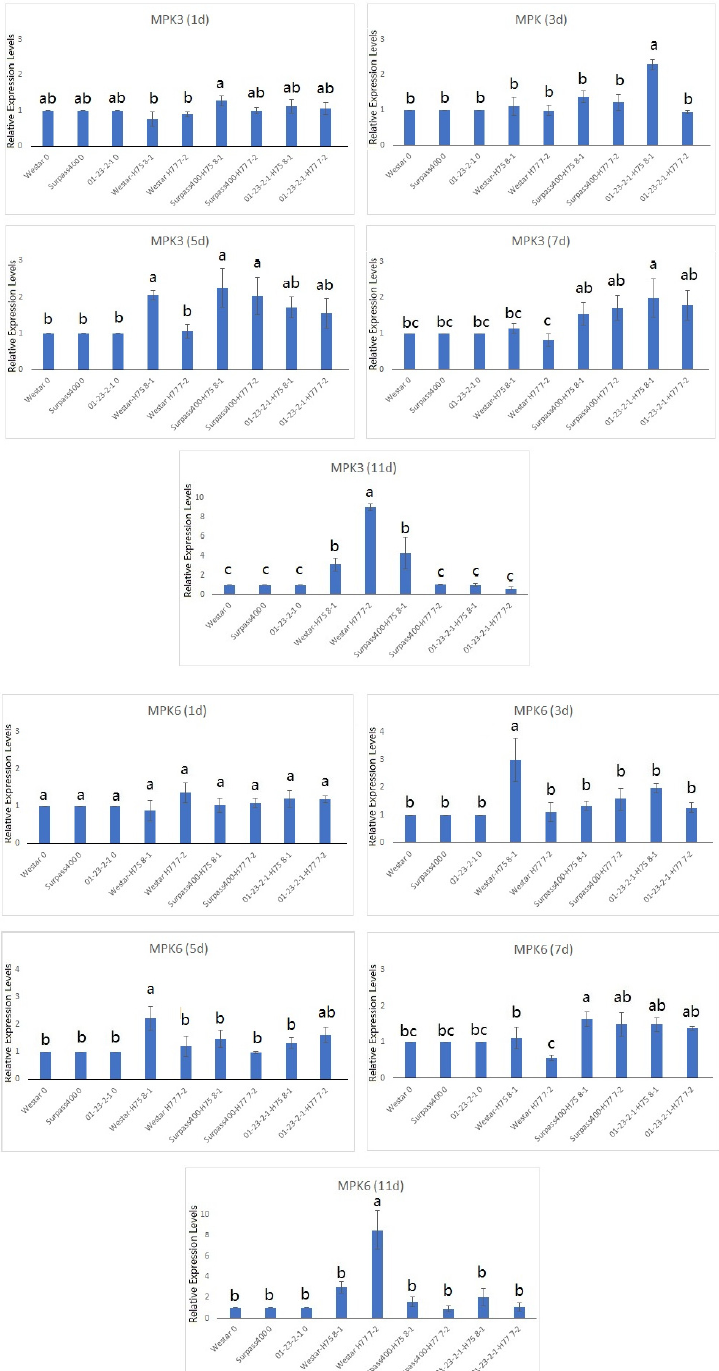
Figure 4. Gene expression of genes related to ROS production ( RBOHD and F ) and ROS signaling ( MPK3 and 6 ). The level of the bars are the expression levels from the inoculated cotyledons (three genotypes: Westar, Surpass400 and 01-23-2-1, two isolates: H75 8-1 and H77 7-2) normalized with the cotyledons inoculated with water (assuming that the expression of each studied gene in the cotyledons inoculated with water is 1). For time point, different lowercase letters suggest the significant differences among mean values (Fisher’s Least Significant Difference; p < 0.05). The results are based on three replicates in three independent